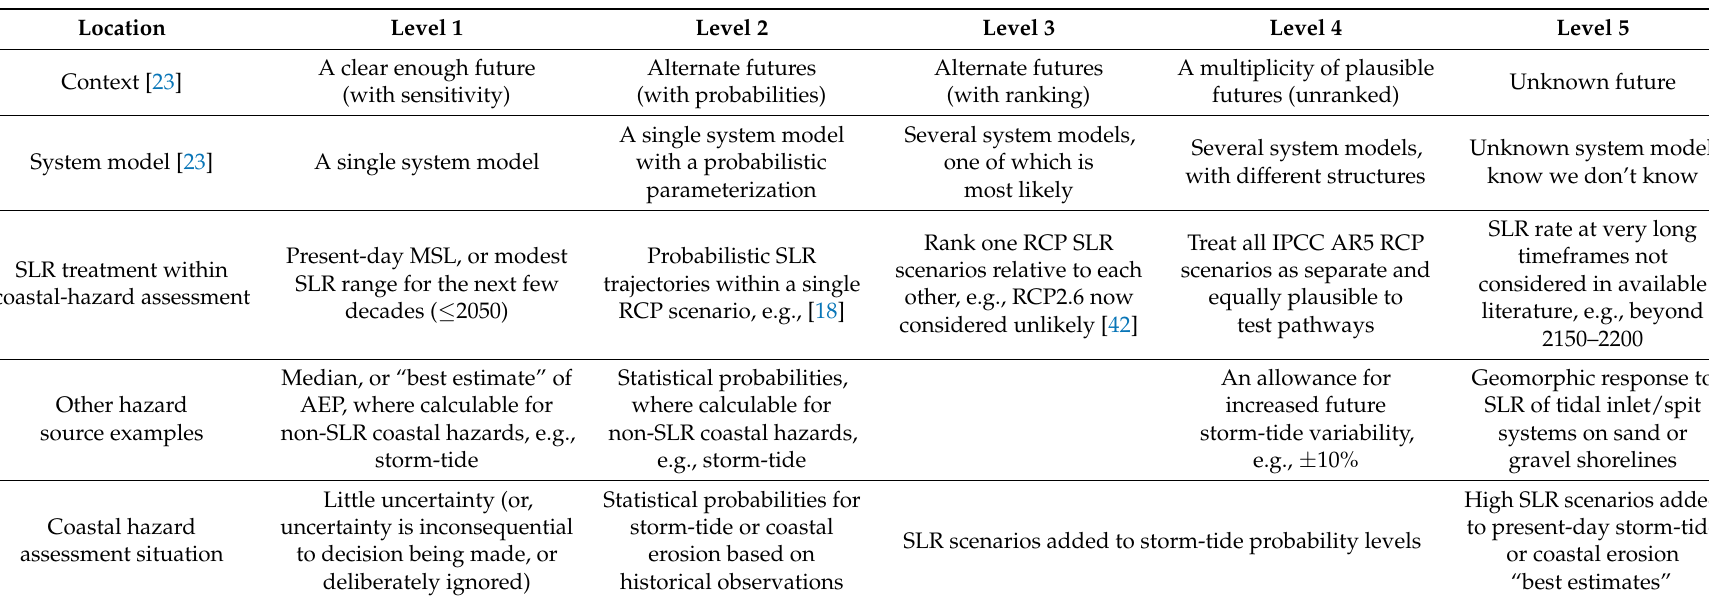
Table 2. The five levels of uncertainty within the uncertainty framework described by Walker et al. [23], including descriptions of the uncertainty levels at the context and system-model locations . We have provided examples of how the uncertainty levels could be related to the treatment of SLR and other hazard sources within a coastal hazard